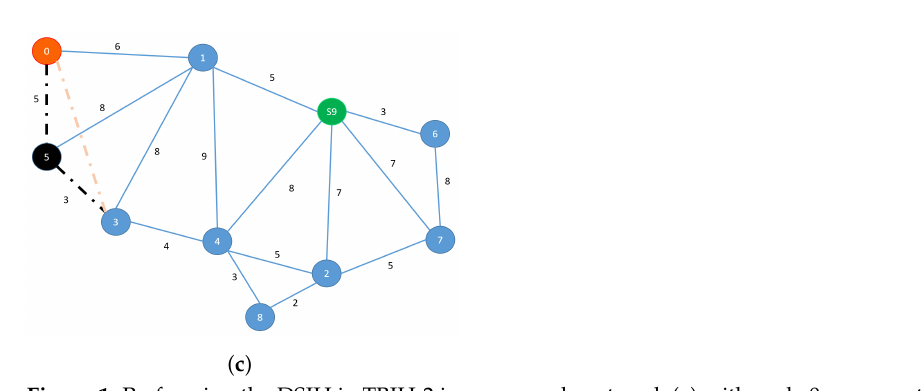
Figure 1. Performing the DSIH in TBIH-2 in an example network ( a ) with node 0 as current position of vehicle m and node S9 as an emergency shelter. The potential seeds j are considered in ( b ) and chosen randomly in ( c ). As a result, node 5 ( υ ) is inserted and route (0–5–3) is constructed. The decision selection specific to the DSIH is highlighted in Algorithm 5. Here, the possible seed candidates are selected based on the neighbours of potential destination υ for vehicle m (lines 3–5). The seed is then randomly selected (line 7) from which the number of potential destinations υ is reduced (line 8). For each of the possible υ , the insertion criteria are evaluated according to the SIH(I1) (lines 9–10), and the insertion of υ is determined (lines 11–12) from which the decision is made and returned (line 18). Algorithm 5 TBIH-2 (with Embedded DSIH)